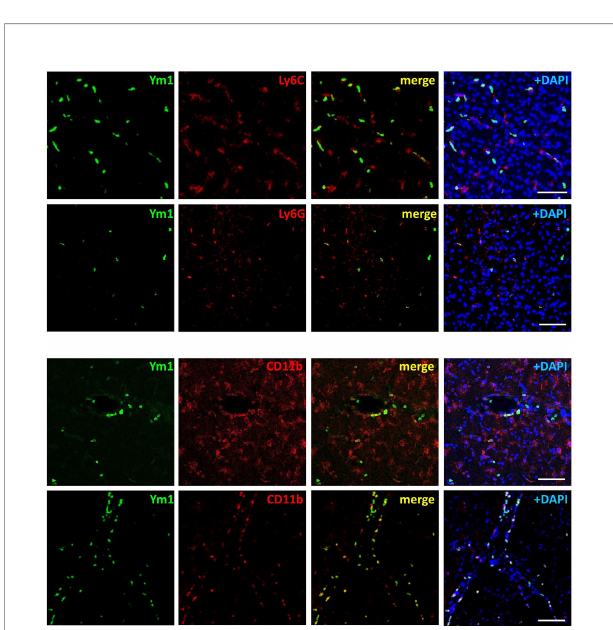
FIGURE 4 | Ym1 is expressed in myeloid cells in fi ltrating from the periphery, resembling monocytes/macrophages and neutrophils. Representative immuno fl uorescence images showing Ym1 expression (green fl uorescence) in CD11b immunopositive myeloid cells (lining the blood vessels and populating the perivascular space), in Ly-6C immunopositive monocytes/macrophages and in Ly-6G immunopositive neutrophils. Nuclei are counterstained with DAPI (blue signal). Scale bars = 50 m